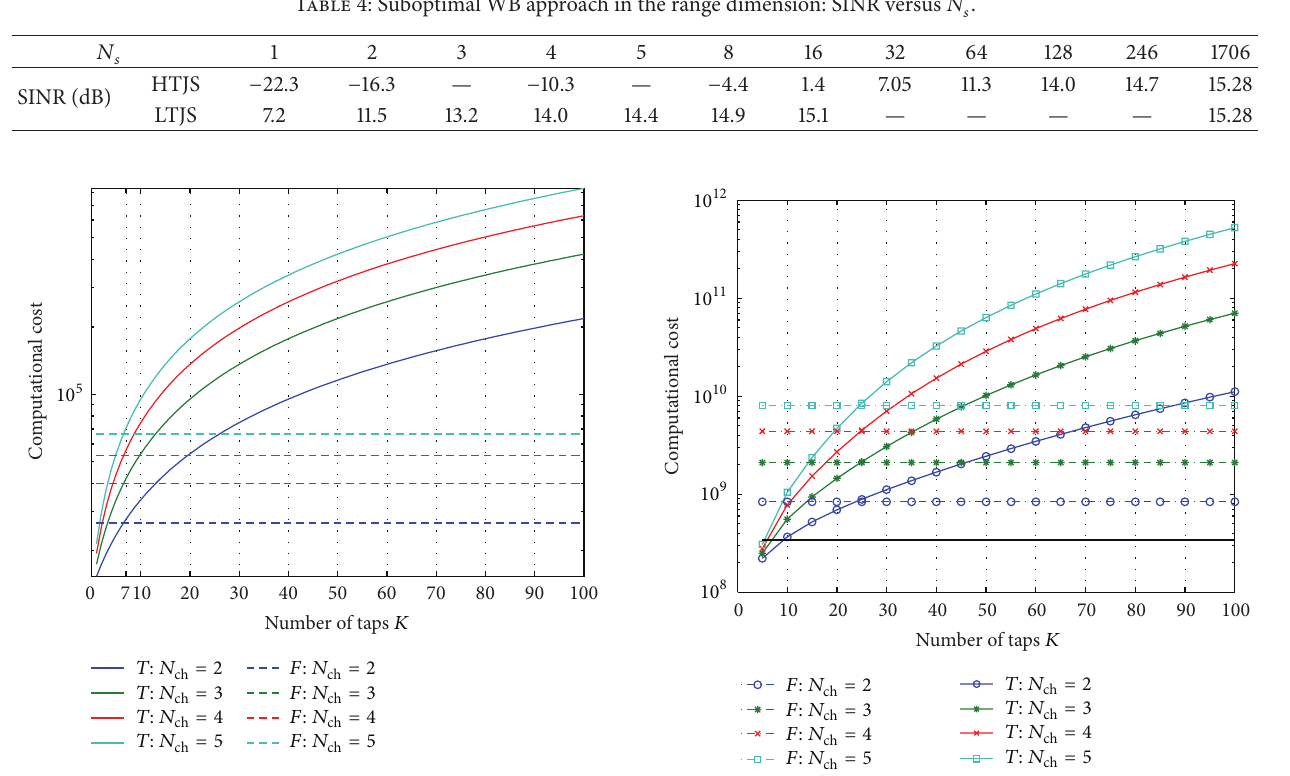
Figure 8: Computational cost of the WB-SLC (labelled with 𝑇 in the legend) for different values of 𝐾 and 𝐶 , compared with the values of the computational cost of the WB frequency nulling SLC (labelled with 𝐹 in the legend) for the same value of 𝐶 .